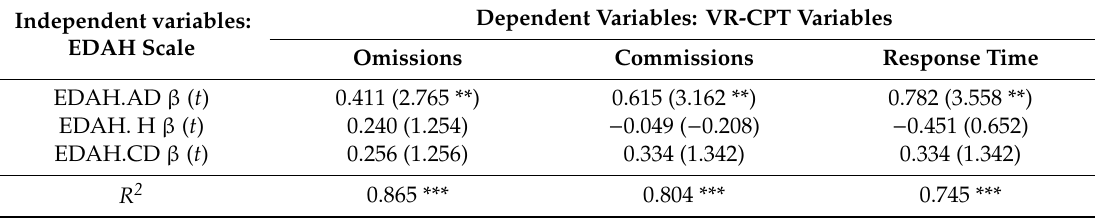
Table 2. Regression models to predict performance in the VR-CPT